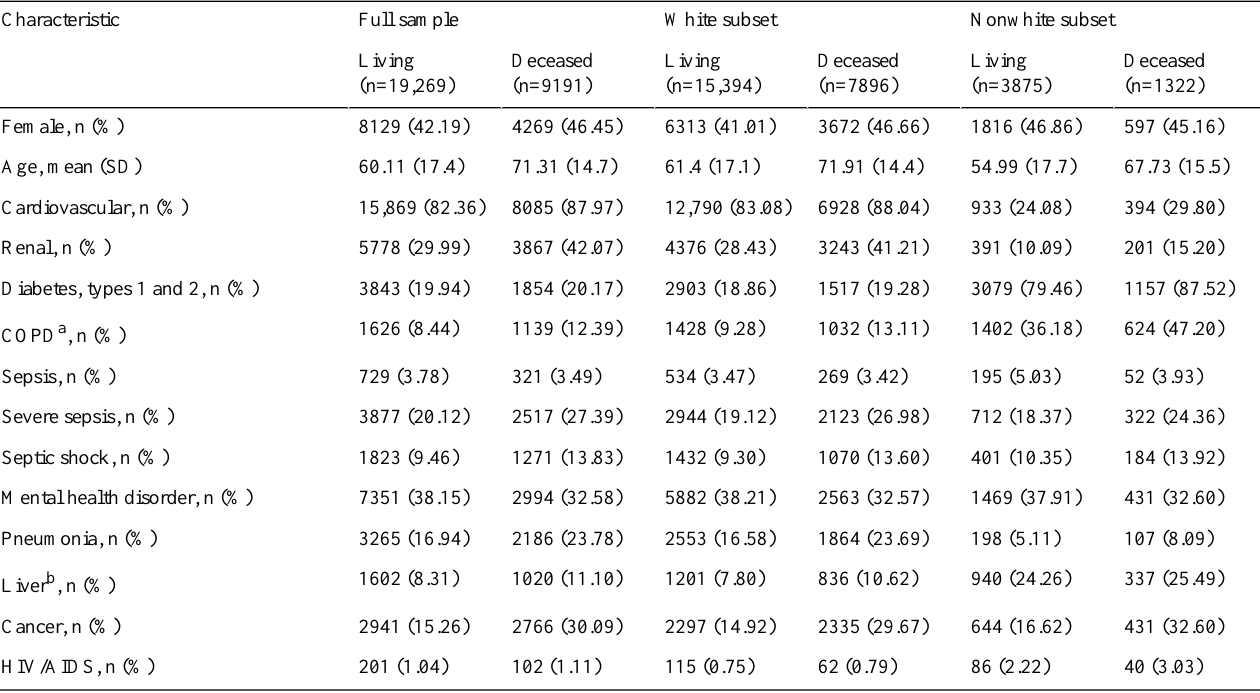
Table 1. Demographic and medical information history for the Medical Information Mart for Intensive Care–III study sample by discharge status.